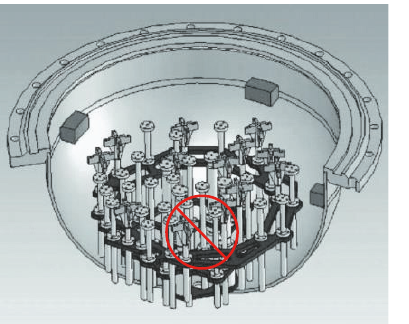
Figure 5: Trimming of the columns.